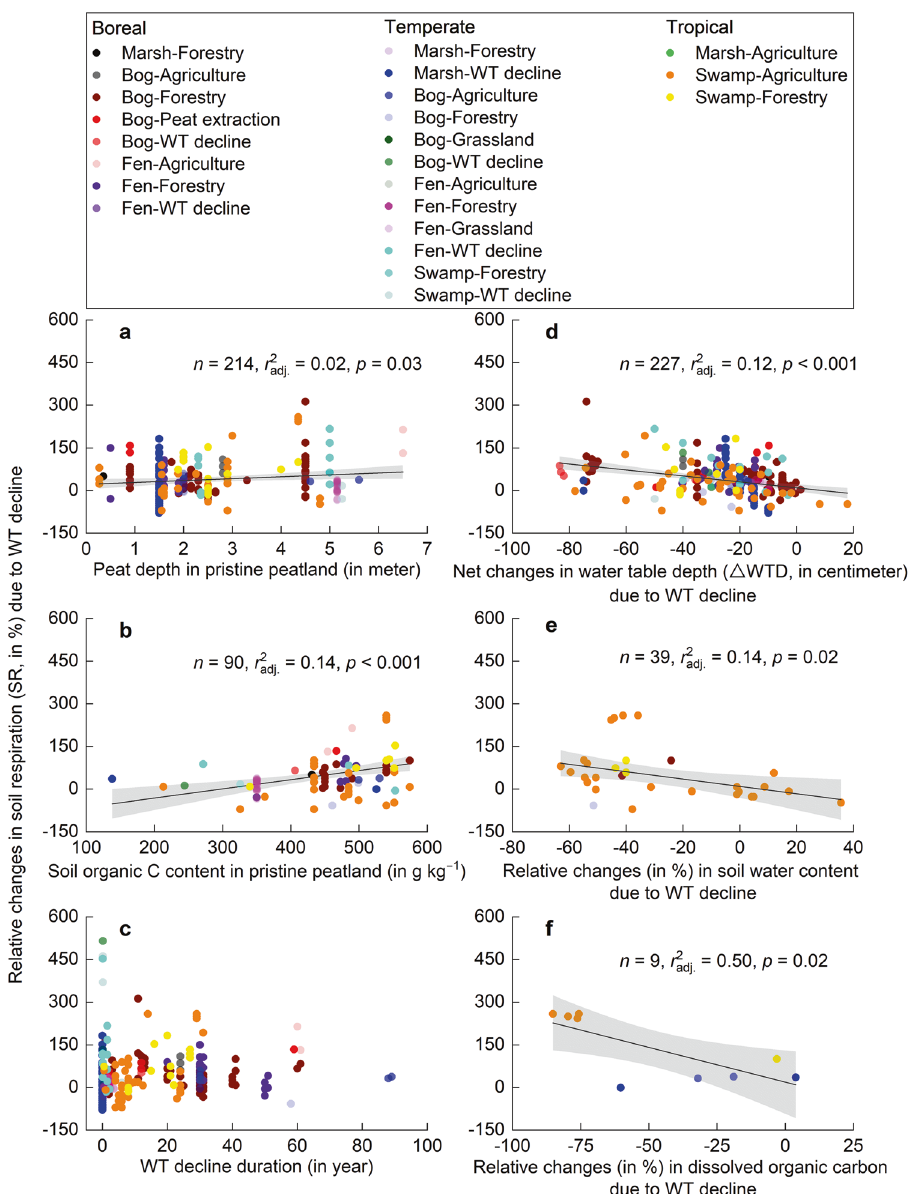
Fig. 4 Relationships between the relative changes in soil respiration (SR) and environmental variables due to WT decline. Relationships between the relative changes in SR and the a peat depth of pristine peatlands, b soil organic C concentration of pristine peatlands, c WT decline duration, d net changes in water table depth, e relative changes in soil water content and f relative changes in dissolved organic carbon concentration due to WT decline. The gray area indicates the 95% con fi dence interval for the fi tted regression curve. We note that the SR observations were classi fi ed based on the climate, peatland type, and driver of WT decline (i.e., land